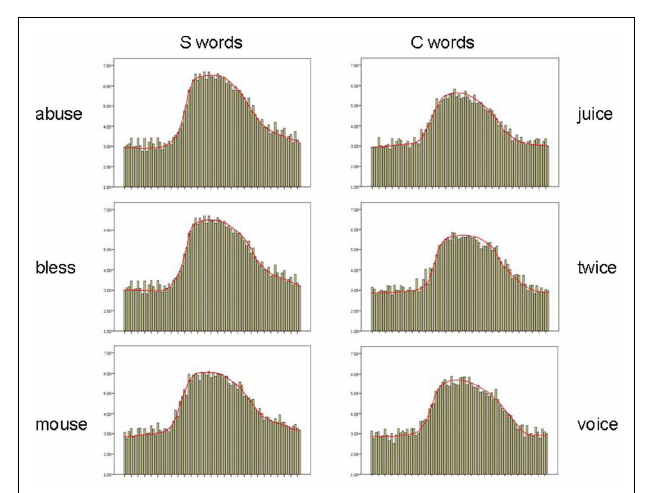
FIGURE 2 | Real words rated by native English-speaking listeners: mean rated goodness as /s/, across the 81-step continuum from /z/ (left) through /s/ to / ∫ / (right), separately for each word spelled with S (left column) or C (right